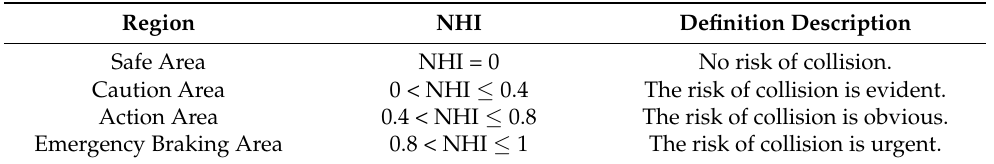
Table 2. Regionalization of the ship collision risk index.